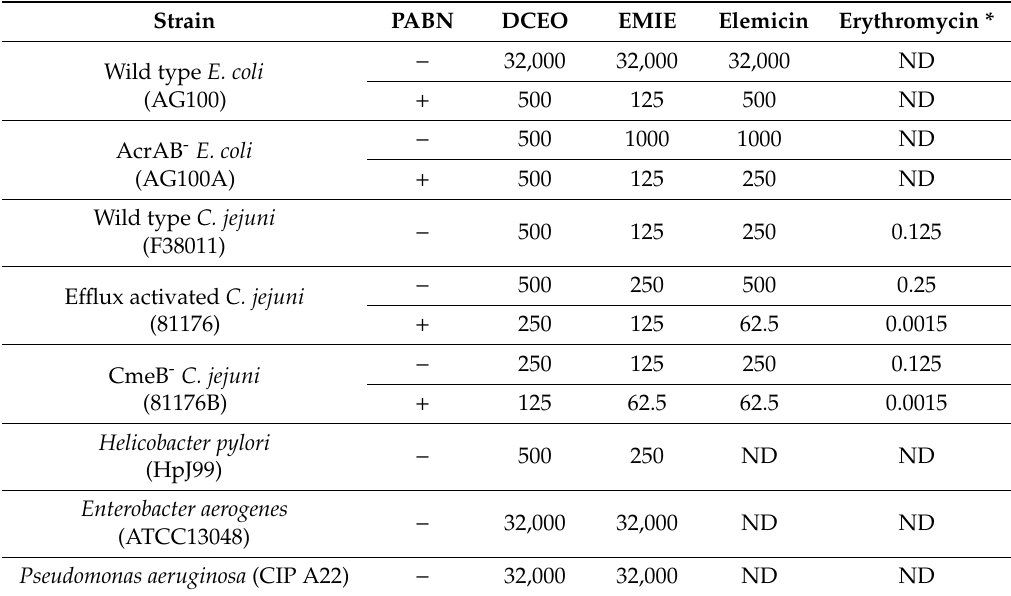
Table 3. MIC of DCEO and active molecules against Gram negative